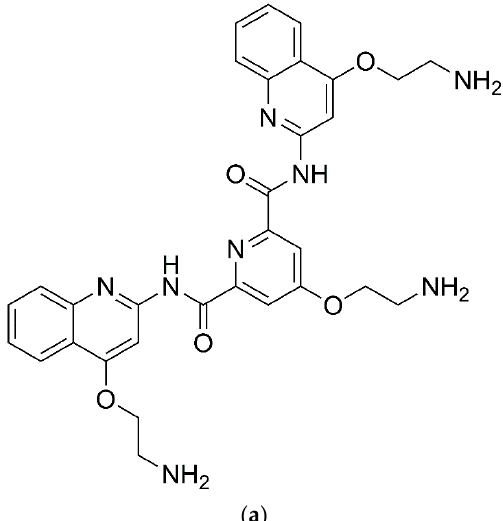
Figure 7. ( a ) Chemical structure of TMPyP4 ( b ) A parallel stranded human telomeric quadruplex in complex with the porphyrin TMPyP4 (PDB: 2HRI).